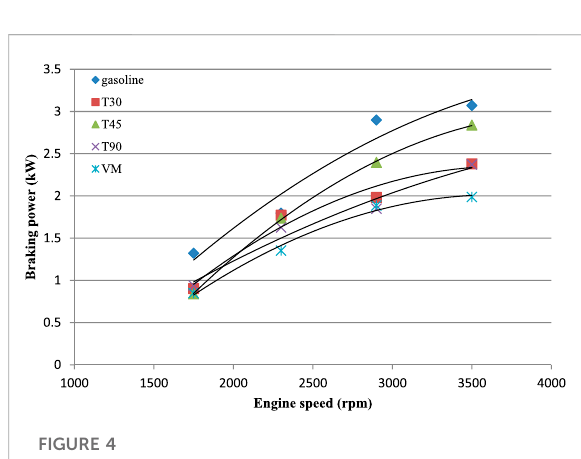
FIGURE 4 The relationship between engine speed and braking power for all types of mixers (gasoline, T30, T45, T90, and